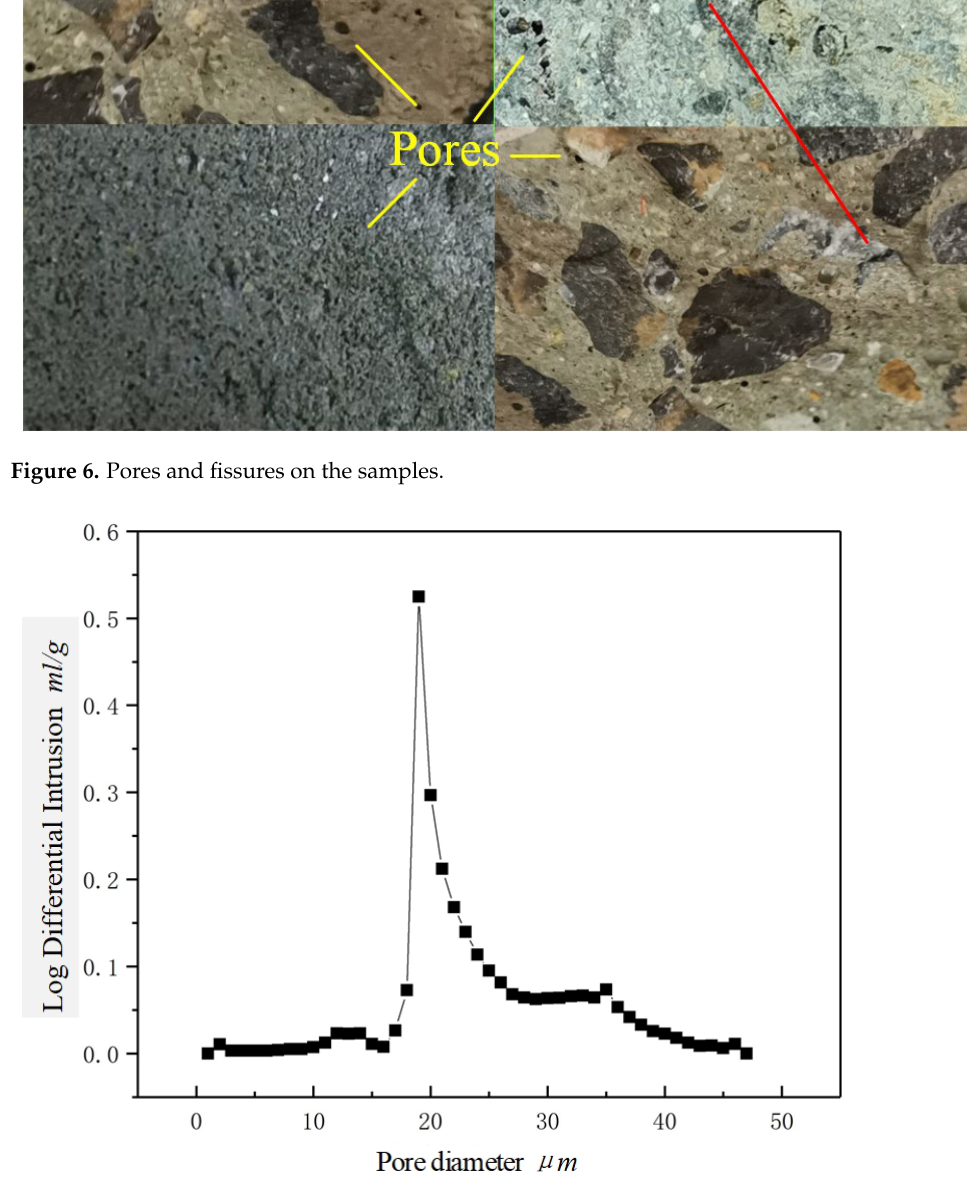
Figure 7. Pore diameter distribution of samples (Mercury penetration experiment).